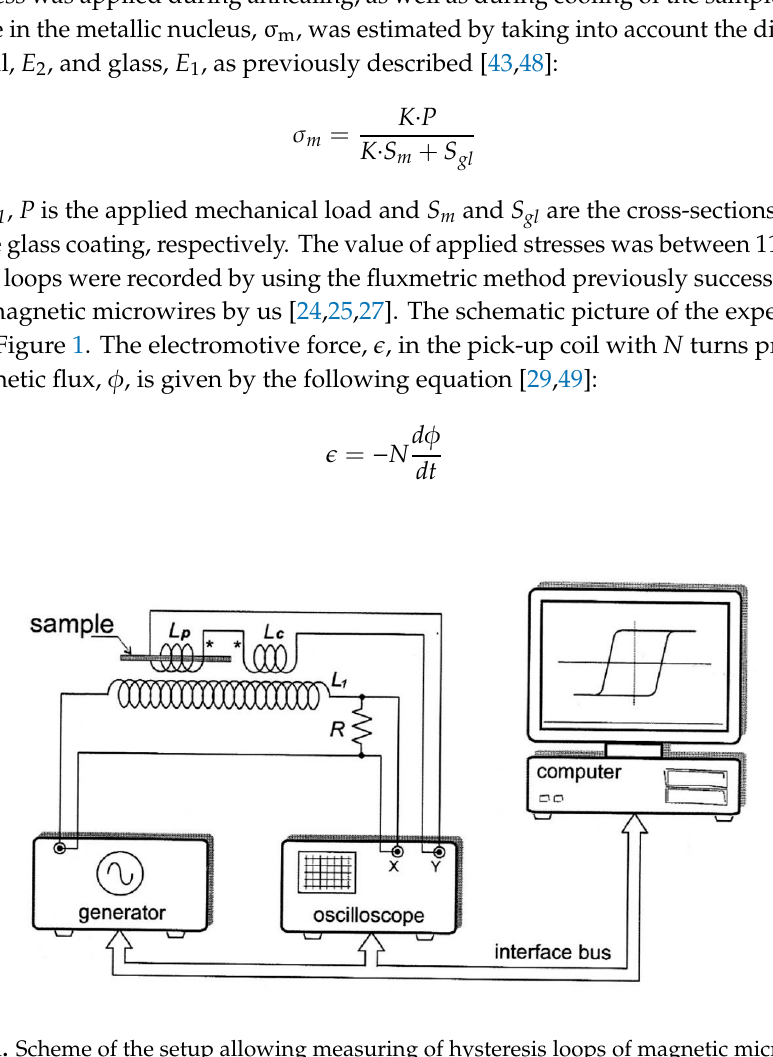
Figure 1. Scheme of the setup allowing measuring of hysteresis loops of magnetic microwires.